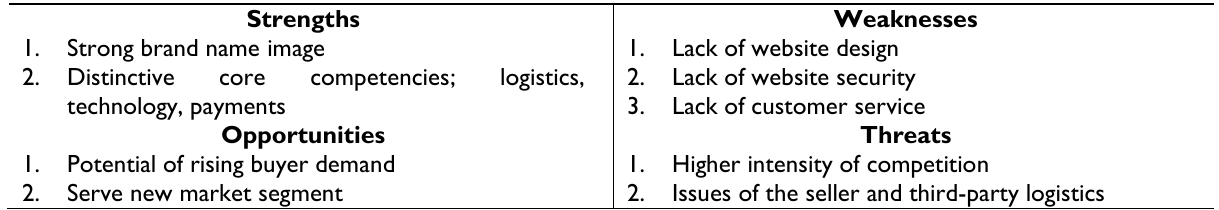
Figure 2: SWOT Analysis for Online Shopping Platform